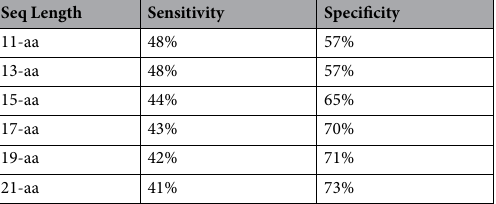
Table 1. Sn and Sp of prediction with different sequence length (SVM).